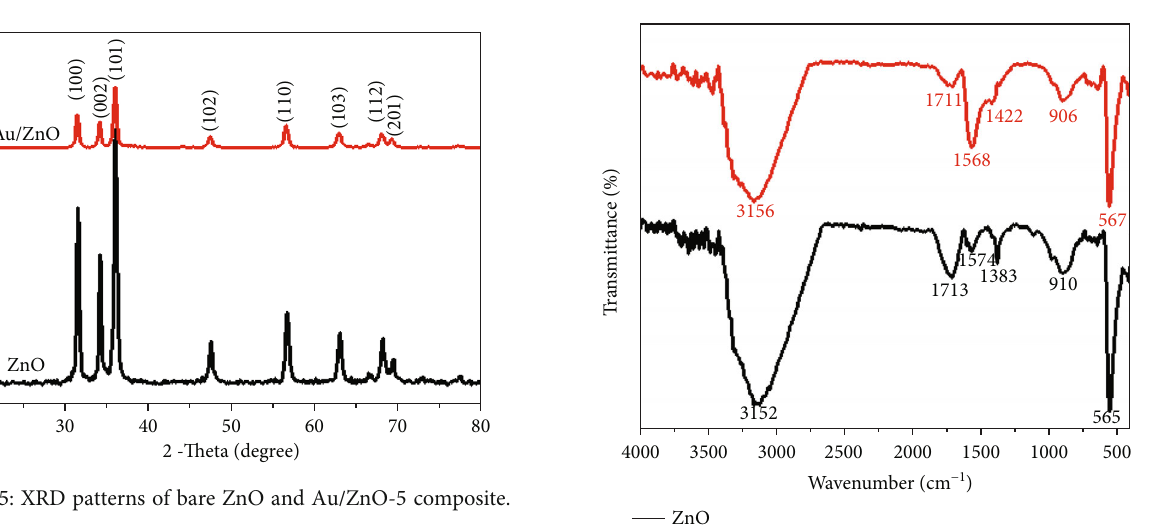
Figure 4: TEM images of (a, b) bare ZnO and (c, d) Au/ZnO-5 composite with the di ff erent scale bars.